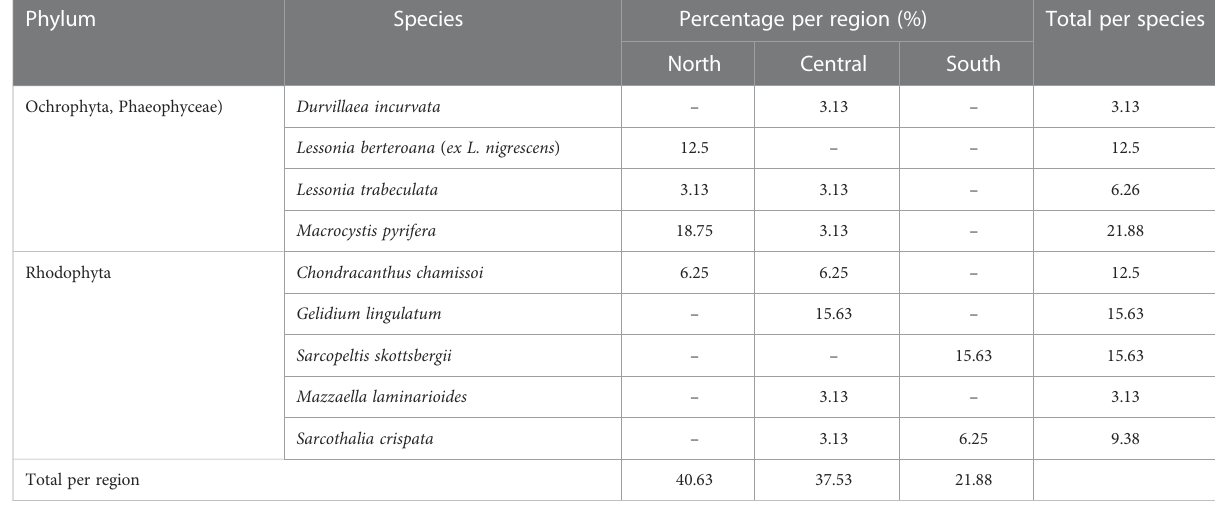
TABLE 1 Restocking studies in Chile. Information obtained and adapted from D ı ́ az (2020). The symbol “–” indicates no availability of information on restocking studies for this species in the area.